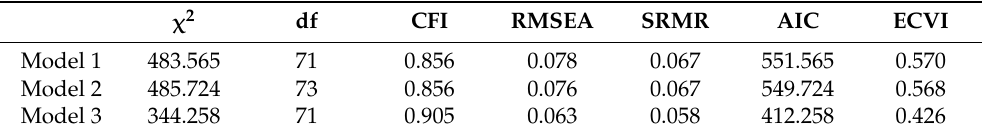
Table 2. Fit indices of Model 1, Model 2, and Model